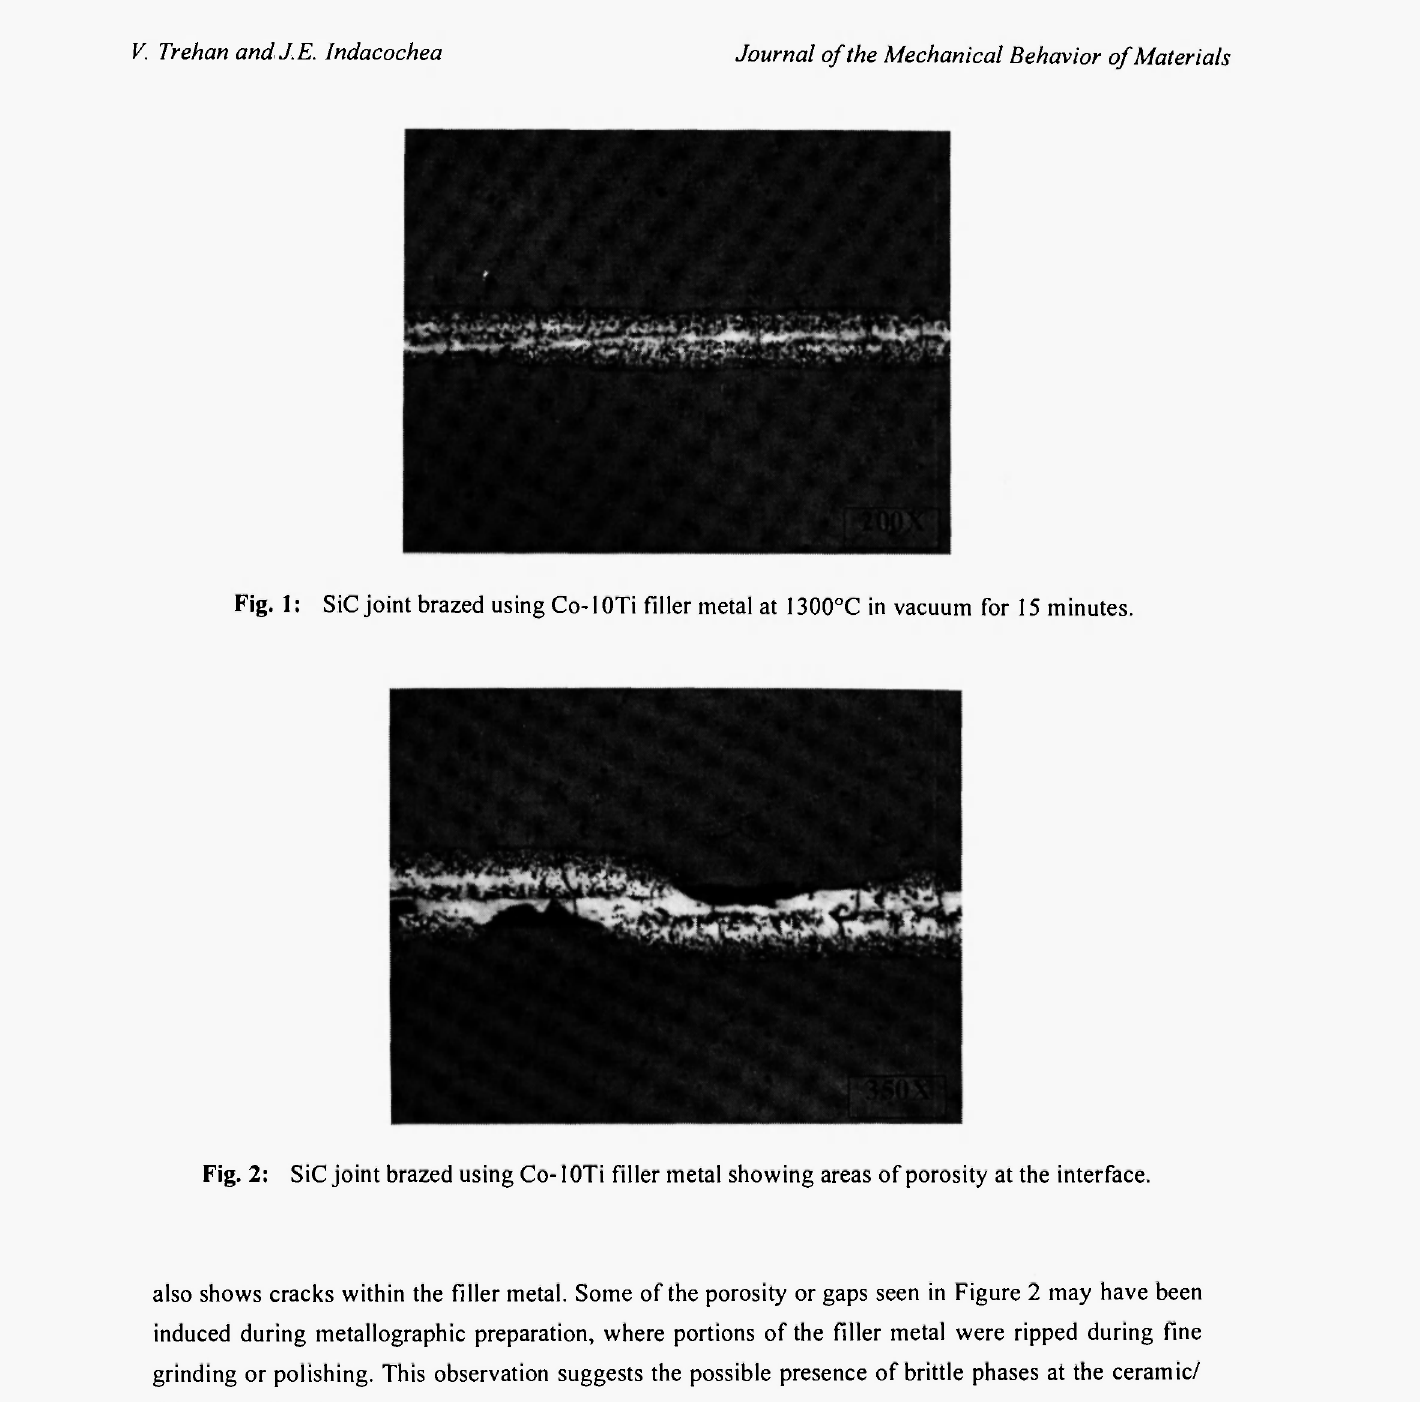
also shows cracks within the filler metal. Some of the porosity or gaps seen in Figure 2 may have been induced during metallographic preparation, where portions of the filler metal were ripped during fine grinding or polishing. This observation suggests the possible presence of brittle phases at the ceramic/ filler metal